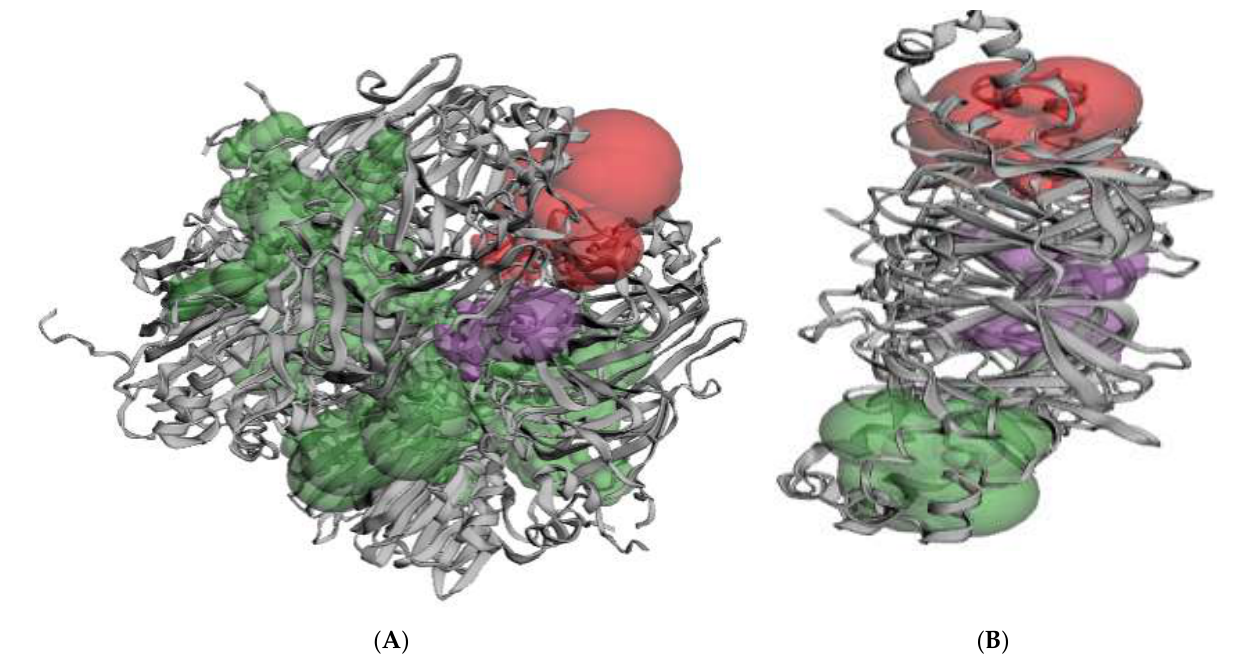
Figure 2. Surface topography of Canola protein ( A ) and Soybean ( B ) (colors represent the three largest pockets).